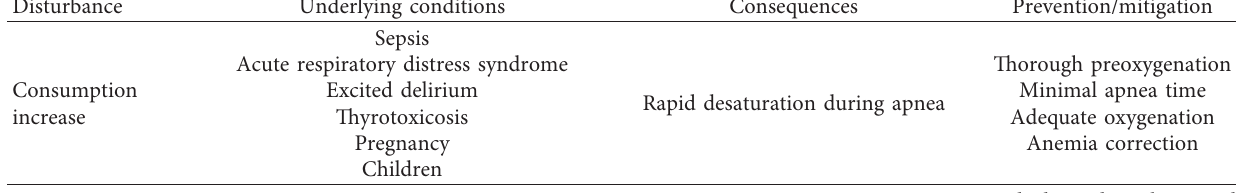
Table 1: Physiologically difficult airway and the common disturbances, underlying conditions, and mitigations.